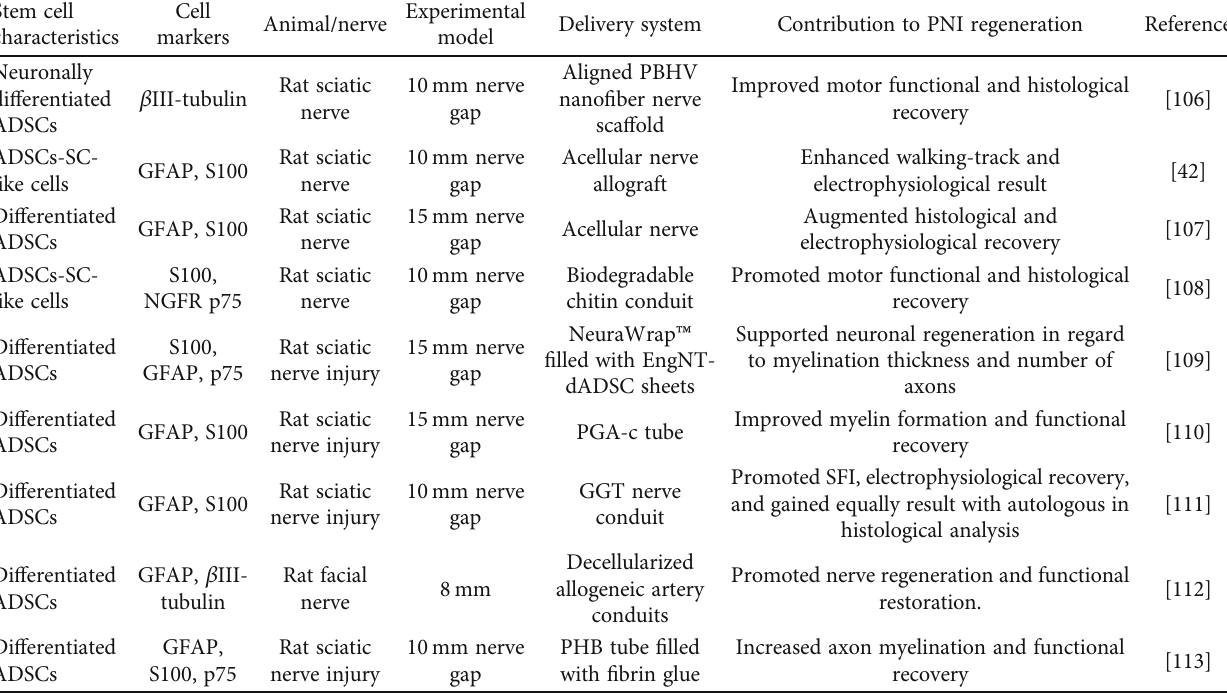
Table 2: E ff ect of dADSCs in PNI animal